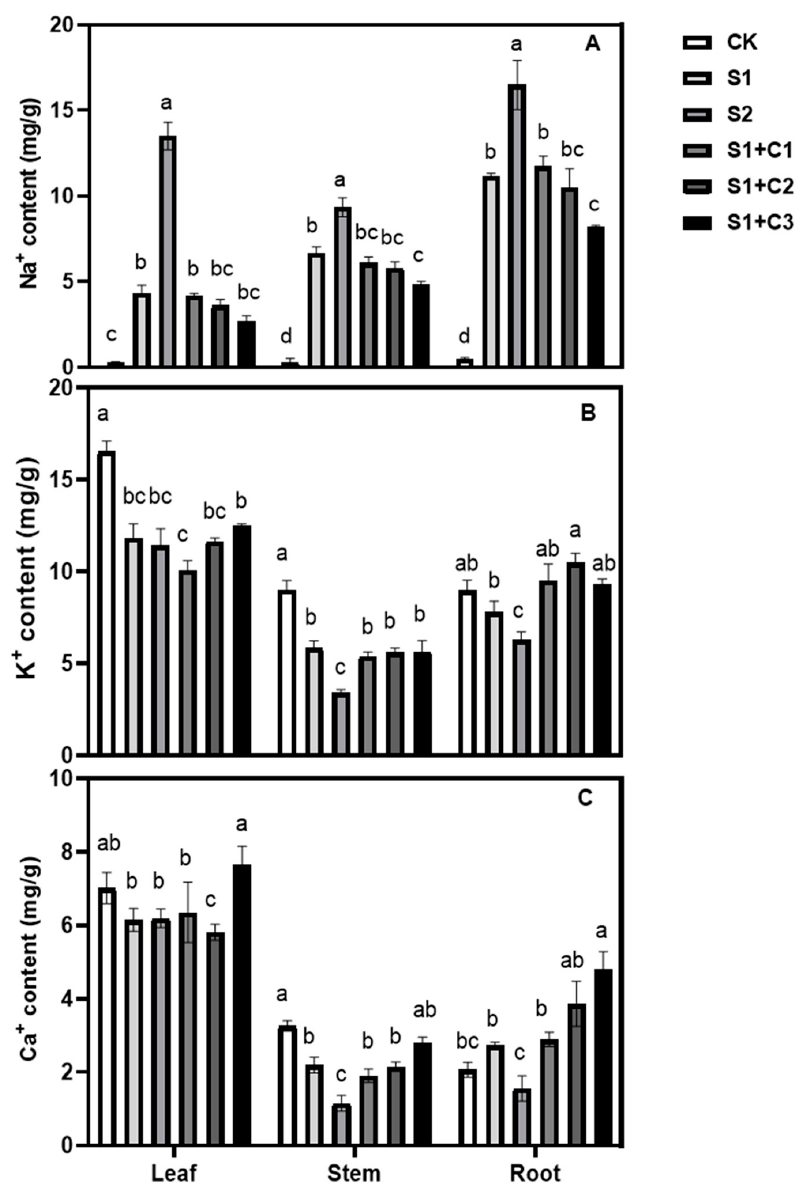
Figure 5. Effects of different salt concentrations and addition of exogenous calcium ions on the contents of Na + , K + , and Ca 2+ in G. sinensis seedlings. ( A – C ) Na + , K + , and Ca 2+ content in different tissue parts of G. sinensis at different salt concentrations and with different concentrations of calcium ions. CK is a G. sinensis plant grown in normal hydroponic culture in Hogland nutrient solution. S1 and S2 are G. sinensis plants treated with concentration of 100 and 200 mmol/L NaCl, respectively; S1+C1, S1+C2, and S1+C3 represent 100 mmol/L NaCl with the addition of 5, 10, and 15 mmol/LCaCl 2 , respectively. The ion content was measured and analyzed by inductively coupled plasma optical emission spectrometry after one week of plant treatment. The data are the average SD of three independent replicates. The mean values represented by the different letters were significantly different in Tukey’s test at p < 0.05.